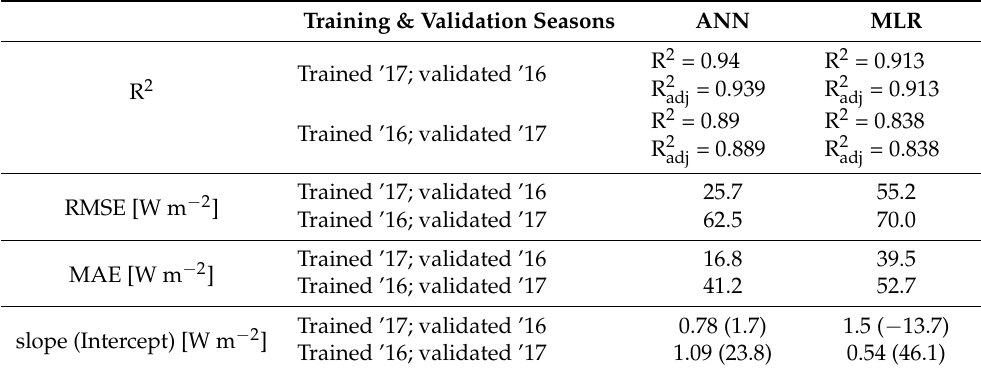
Table 3. Regression results of R 2 , RMSE, MAE and slope for ANN and MLR. Training and validation were done on data sets from different seasons. Modelled—Y-axis;